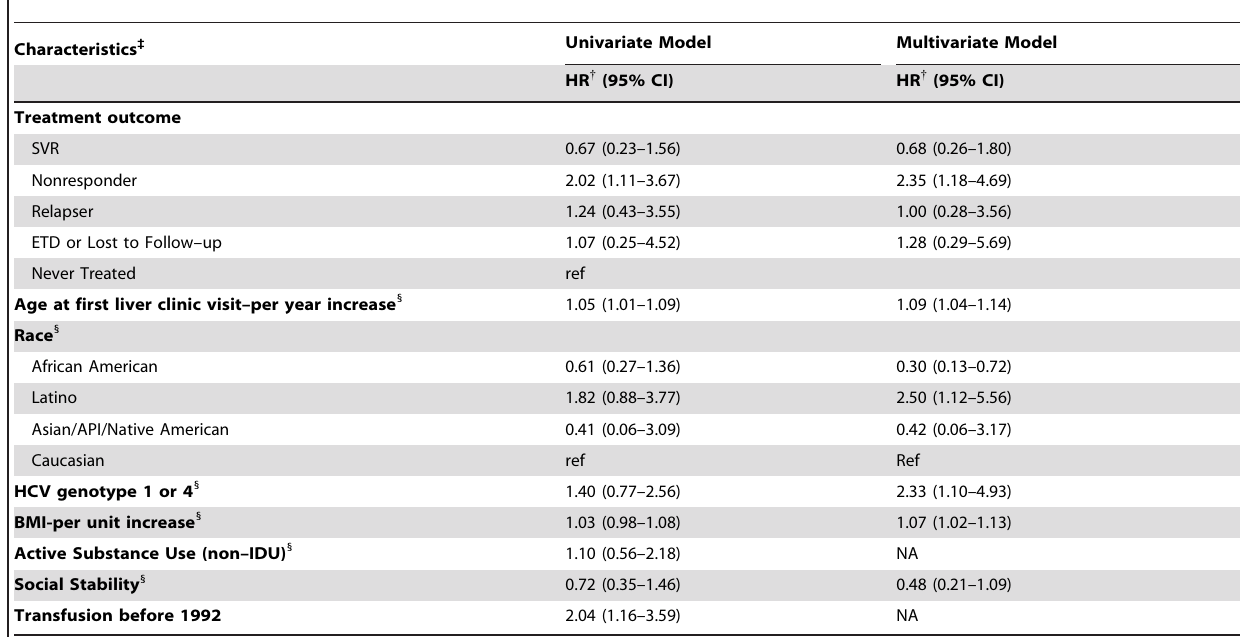
Table 3. Predictors of Development of Cirrhosis Stratified by Fibrosis Stage (SFVA Cohort, N=332)*.